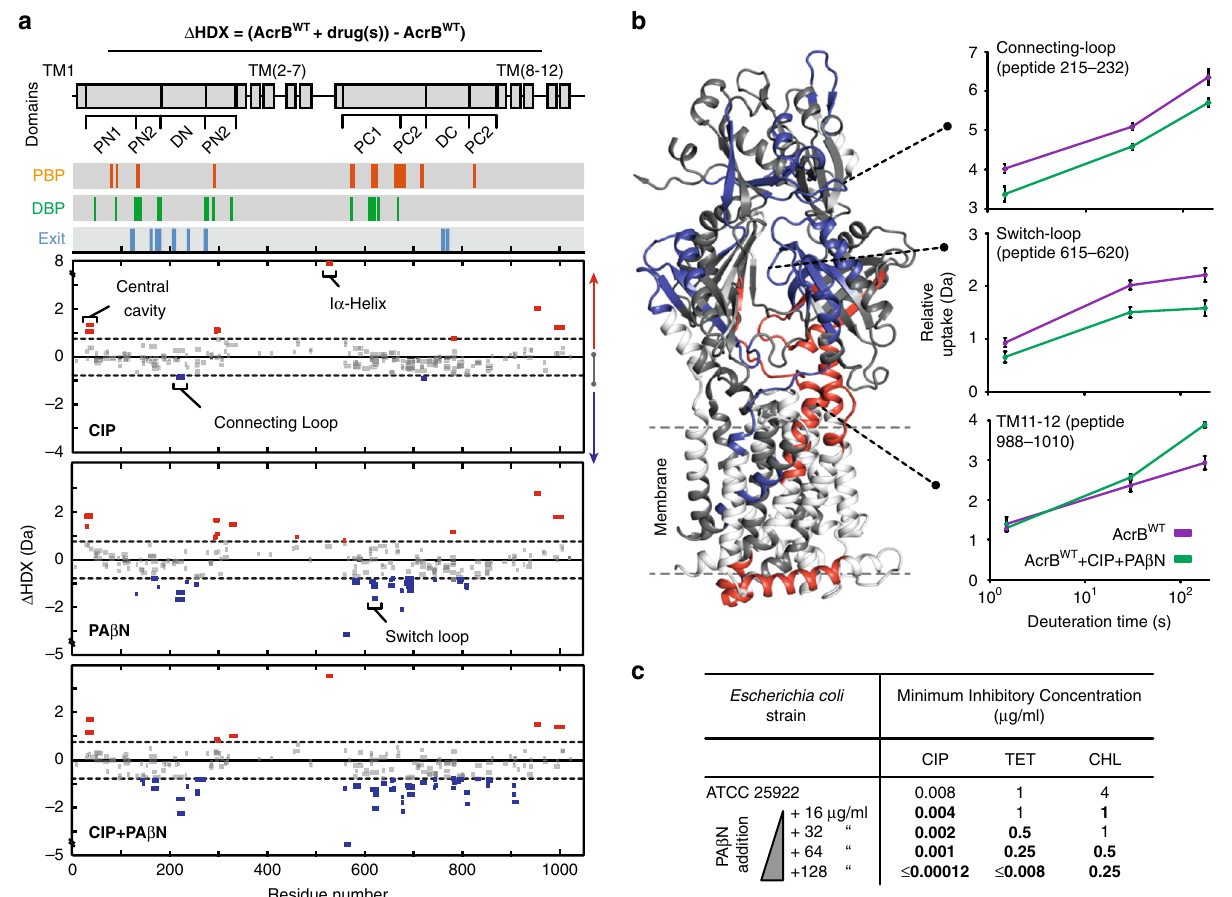
Fig. 2 Effect of EPI PA β N on AcrB structural dynamics and function. a Sum differential HDX ( Δ HDX) plots for different drug conditions ( Δ HDX = (AcrB WT + drug(s)) − AcrB WT ) for all time points collected. Red signi fi es peptides with increased HDX between states and blue represents peptides with decreased HDX. 98% con fi dence intervals are shown as grey dotted lines and grey data are peptides with insigni fi cant Δ HDX. All measurements were performed at least in triplicate. All supporting HDX-MS peptide data can be found in the Source Data fi le. b Δ HDX extent for (AcrB WT + CIP + PA β N) – AcrB WT is coloured onto the L-state monomer of AcrB (PDB:2HRT) using Deuteros 34 . Connecting-loop from the adjacent monomer is included. Uptake plot data are the average and standard deviation from repeated measurements ( n = 3). c MIC assays of Escherichia coli in the presence of inhibitor and antibiotics. Values that demonstrate >2-fold reduction in MIC are in bold. Cipro fl oxacin = CIP, Tetracycline = TET, Chloramphenicol = CHL, and phenylalanine-arginine- β -naphthylamide = PA β N. MIC for PA β N alone is 256 μ